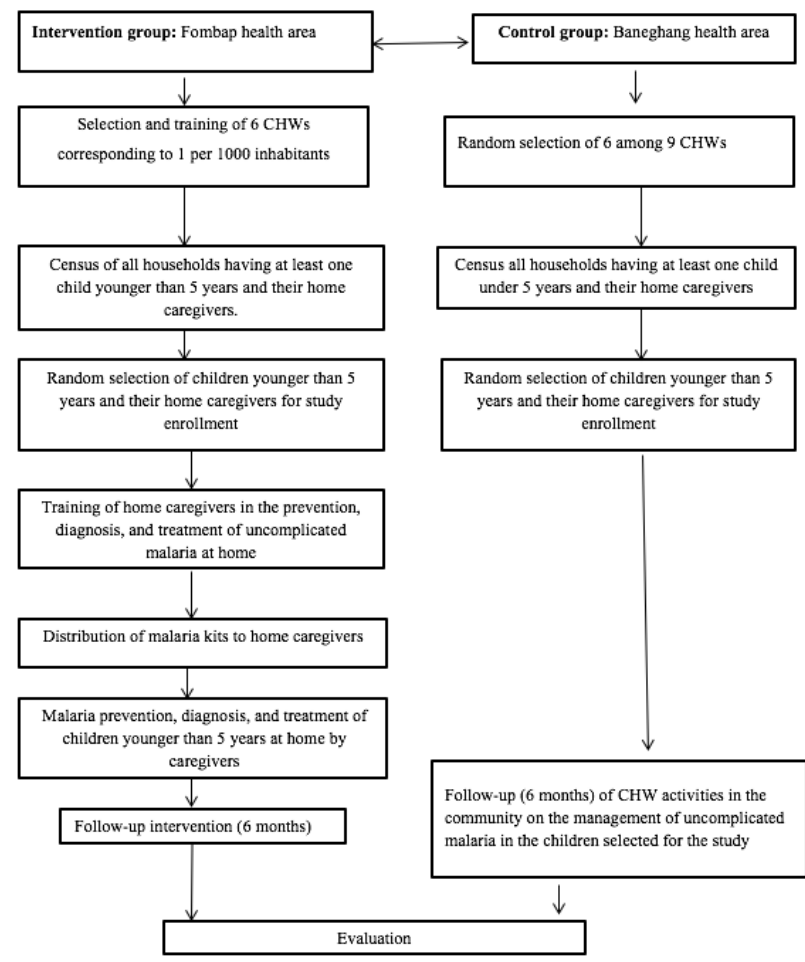
Figure 2. Flow chart showing the sampling method for the intervention